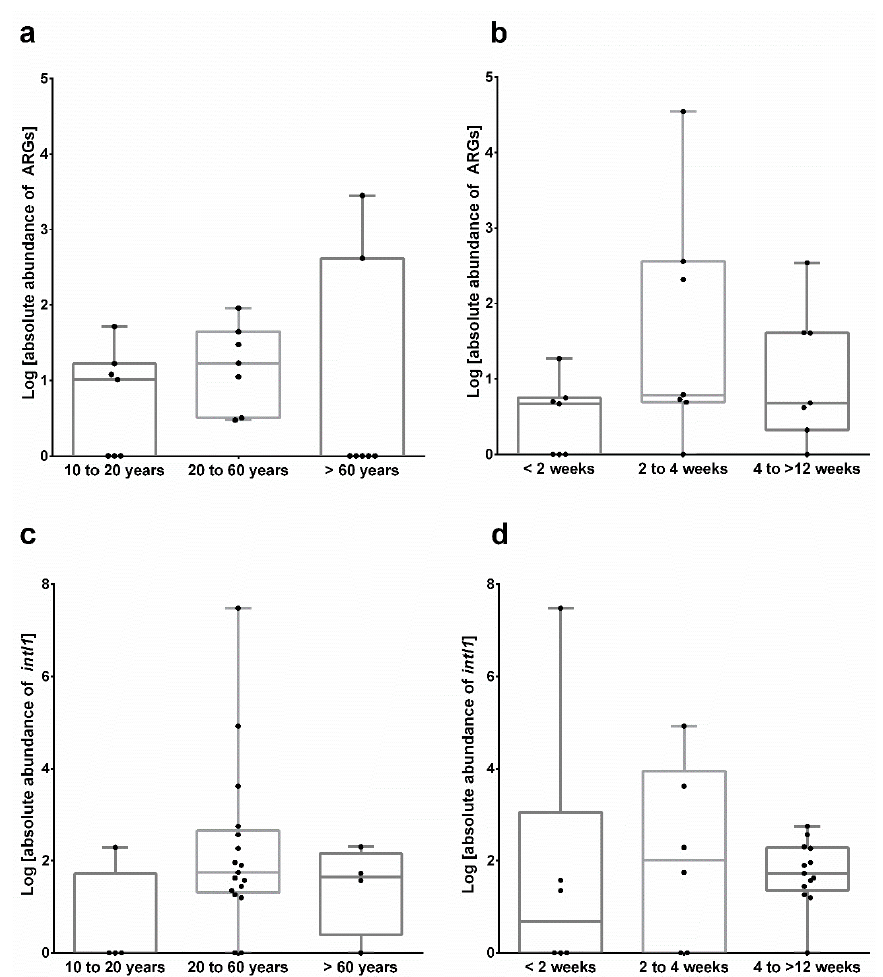
Figure 5. Absolute abundance of total ARGs ( a , b ) and intI1 ( c , d ) of toothbrush samples grouped by